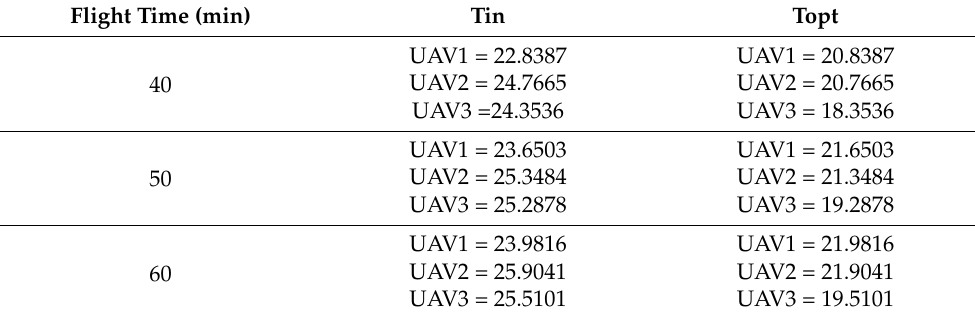
Table 3. UAV in Flight Operation.